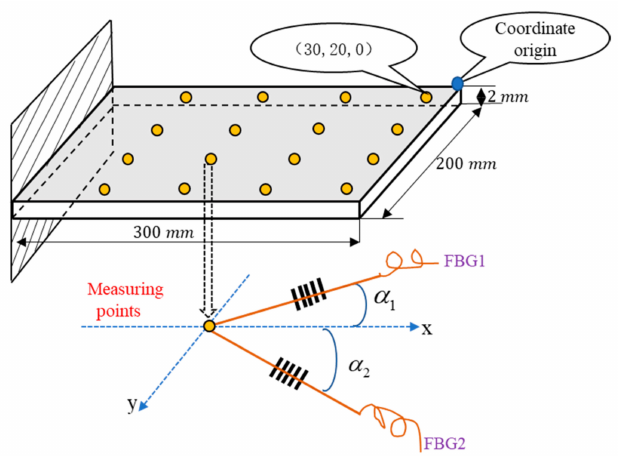
Figure 1. Structural drawing of a test piece with a flexible thin-walled